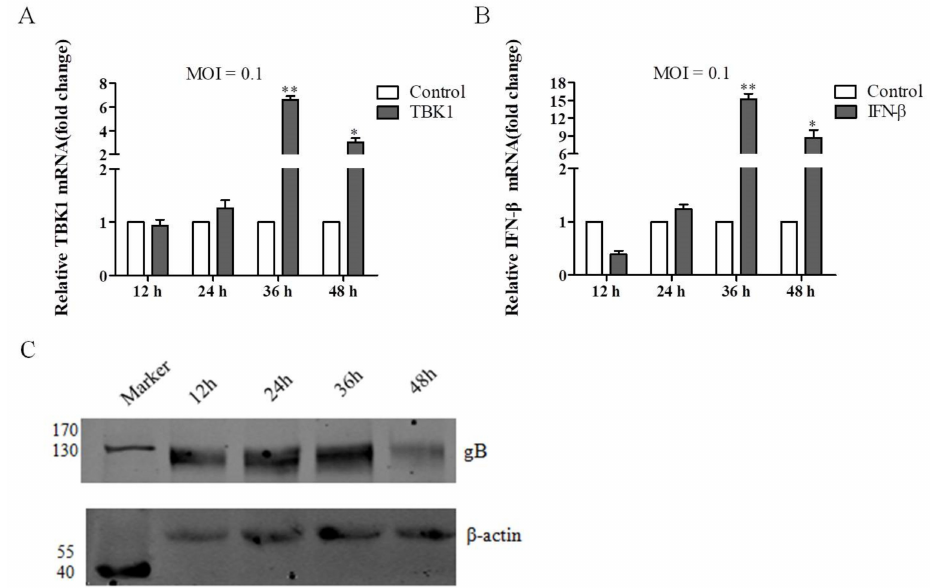
Figure 1. Effects of DEV infection on the expression levels of TBK1 and IFN- β in vitro. DEF cells were infected with DEV at a MOI of 0.1 for indicated time points, and cell samples were collected, respectively. ( A ) The qRT-PCR results of TBK1 gene expression in DEF cells at a MOI of 0.1. ( B ) The qRT-PCR results of IFN- β gene expression in DEF cells at a MOI of 0.1. ( C ) The expression levels of DEV gB in DEF cells at indicated time points by western blot assays, with β -actin protein as the control. Mean ± SD of three technical replicates are shown. * p < 0.05, ** p <